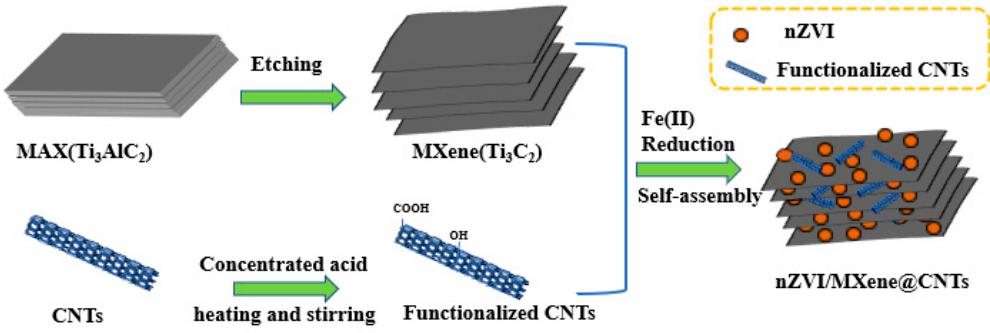
Figure 1. Schematic illustration of the self-assembly synthesis of nZVI/MXene@CNTs.